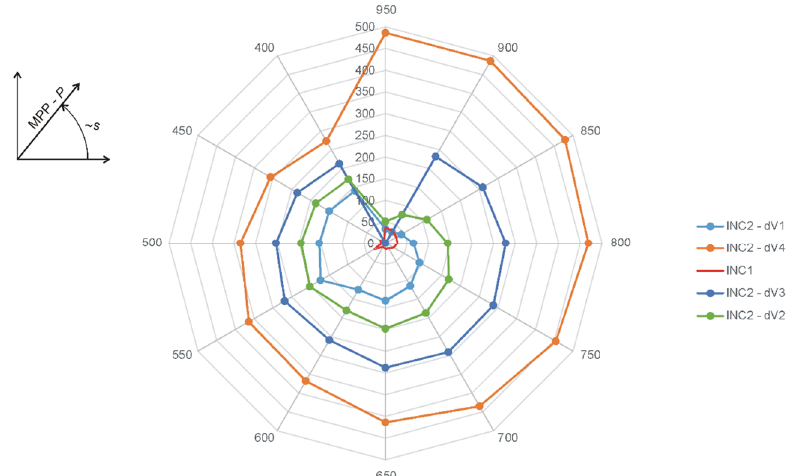
Figure 13. Measured power losses in W delivered to the grid using: proposed MPPT (INC1); with the incremental conductance MPPT (INC2) for different values of the voltage increment (d V 1, d V 2, d V 3, d V 4) under solar irradiances s ranging from 400 to 900 in W/m 2 .